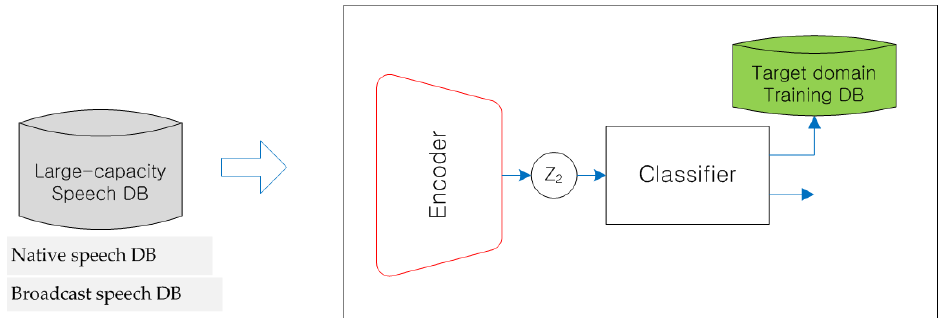
Figure 3. Graphical illustration of the data selection step.